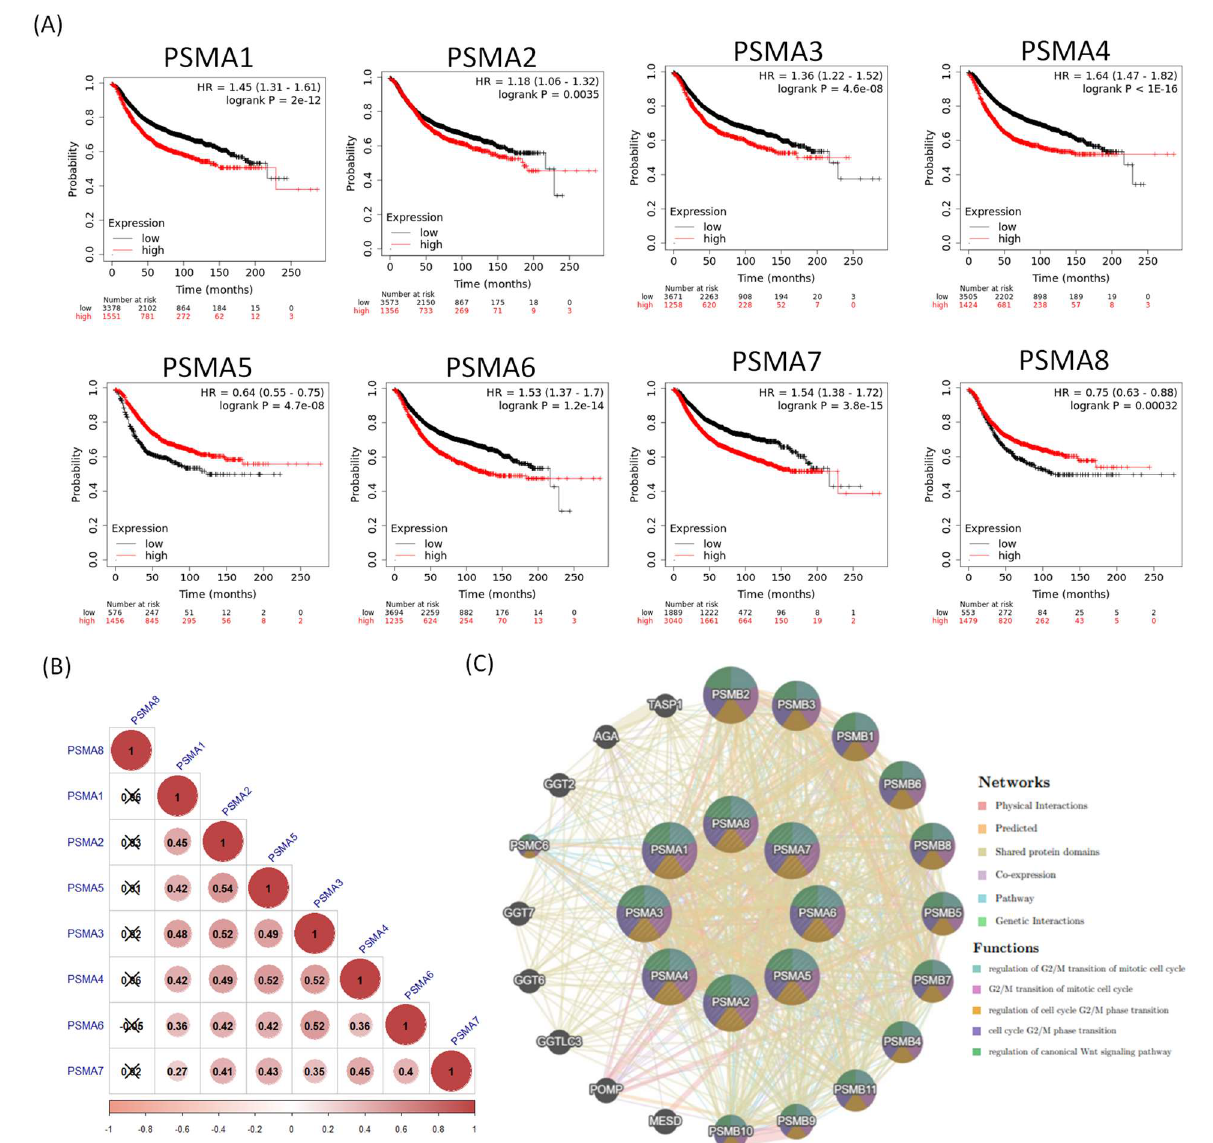
Figure 4. Prognosis and correlation analysis of proteasome 20S subunit alpha ( PSMA ) family genes in breast cancer patients. ( A ) A recurrence-free survival (RFS) dataset was used for the analysis. An auto-cutoff was applied in this analysis to differentiate patients into two groups based on the best cutoff value of PSMA mRNA. Higher and lower expression levels of PSMA mRNA than the cutoff value are, respectively, indicated in red and black. Significant correlations were shown between high expression levels of PSMA1, PSMA2, PSMA3, PSMA4, PSMA6, and PSMA7 with poor survival outcomes in breast cancer patients (n = 4929). ( B ) Correlations between PSMA family genes in breast cancer patients, and insignificant correlations are marked by crosses. ( C ) Co-regulated molecules for PSMA family genes were analyzed with the GeneMania platform. GeneMania